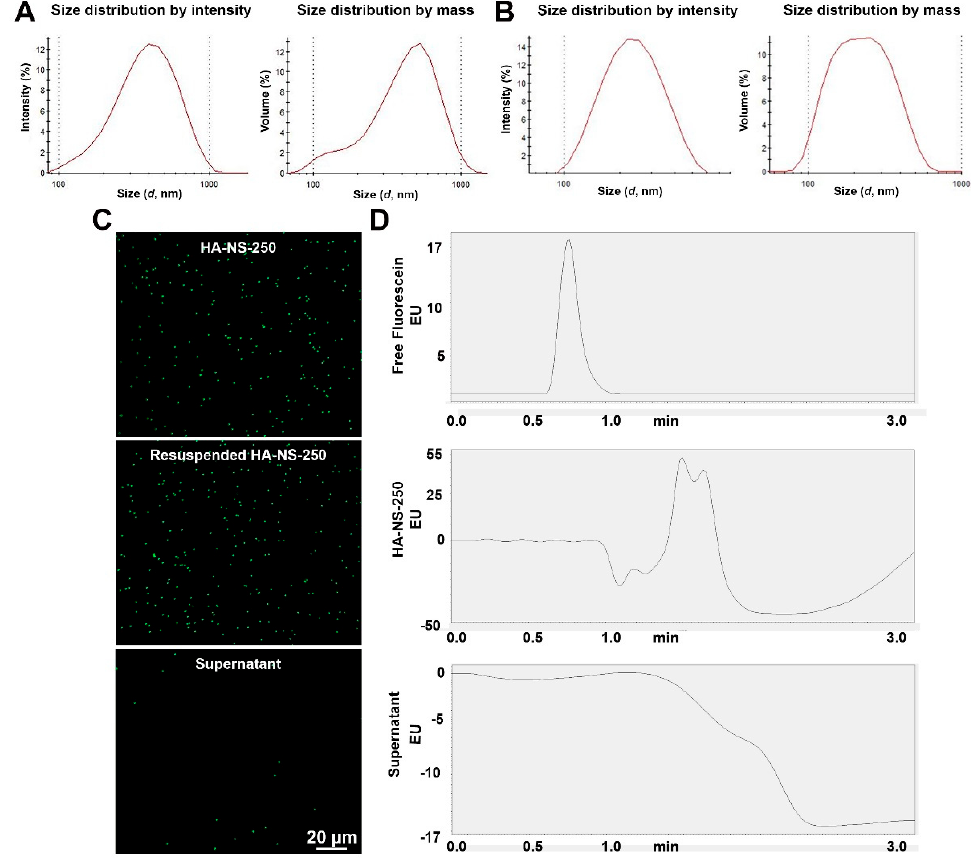
Figure 1. Characteristics of fluorescein-conjugated HA-NS-250. ( A , B ) Dynamic light scattering was used to characterize the size of the HA-NS-500 ( A ), and HA-NS-250 ( B ). ( C ) Nanospheres were diluted in saline and imaged under a fluorescence microscope (top image) after being pelleted and resuspended (middle image), no significant aggregation is observed, and very little fluorescein is detected in the supernatant (bottom image). ( D ) To confirm that fluorescein is not being released from NS, fluorescein (positive control, top), resuspended HA-NS-250 (middle), and supernatant (bottom) from pelleted HA-NS-250 underwent HPLC. Shown are HPLC traces; no signal is detected in supernatant. EU: emission unit. Scale bar 20 µ